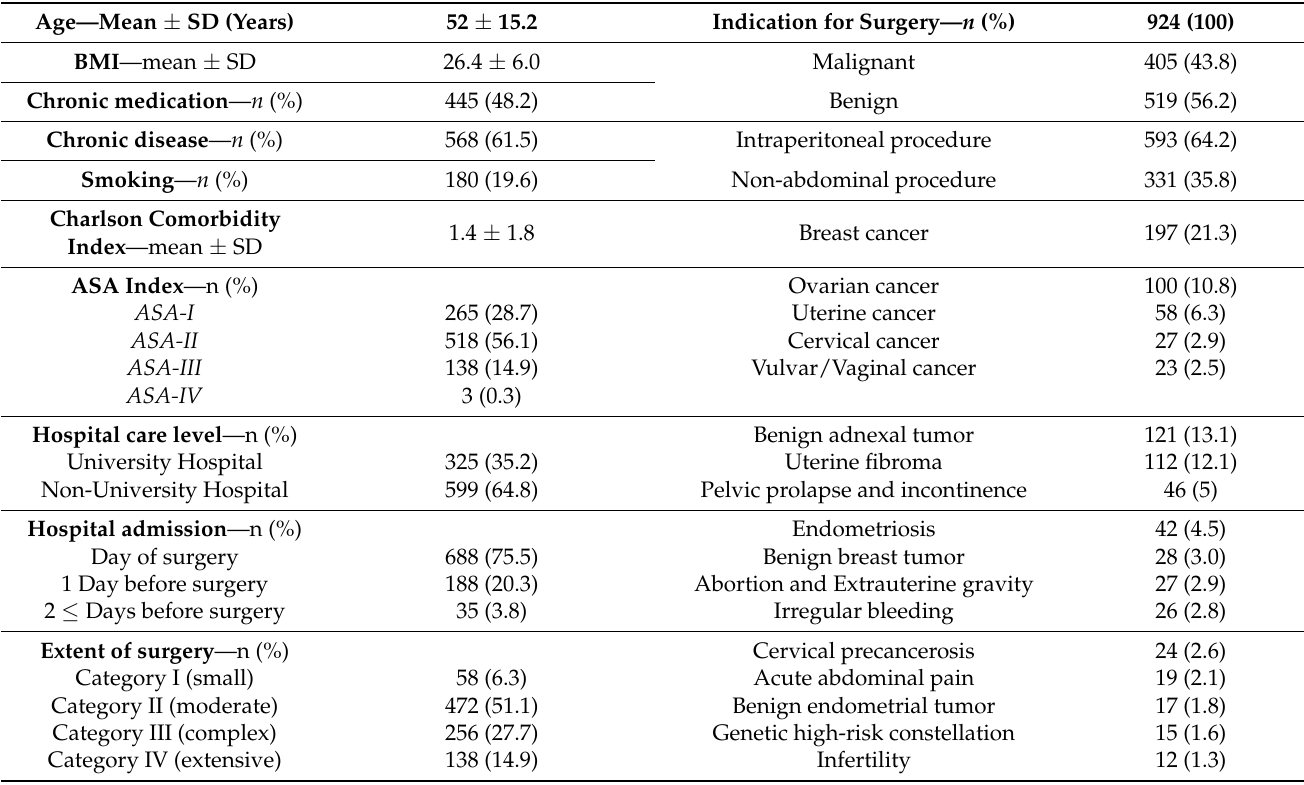
Table 1. General characteristics. Patient and procedure related characteristics are displayed. On the righthand side, indications of performed procedures are further specified. SD = Standard deviation, n =